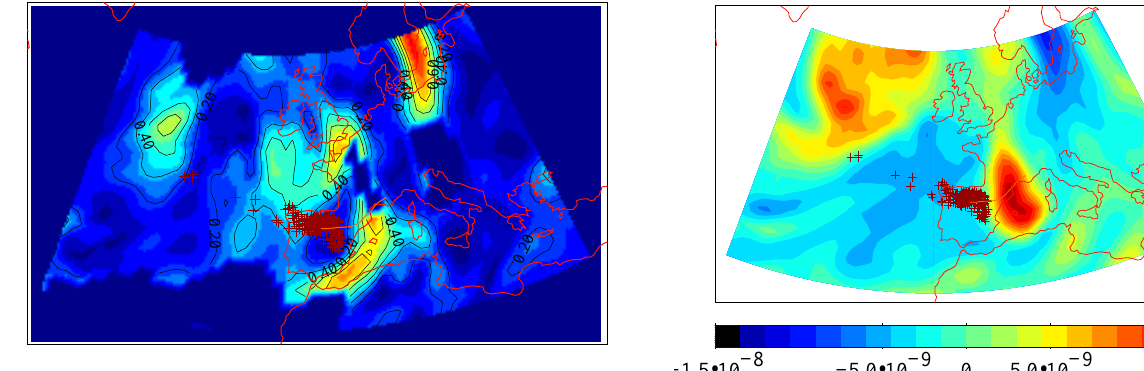
Fig. 9. Lagrangian Rossby number on the 340 K isentrope on 2 September 1997 at 14:00 UTC. Isocontours are drawn for Ro = 0 . 1 , 0 . 2 , .... The Rossby number was not calculated when v h ≤ 10 m s − 1 . The trajectory of the “observed ray” is also shown (or- ange curve), as well as the advected intersection of the rays with that surface (crosses).